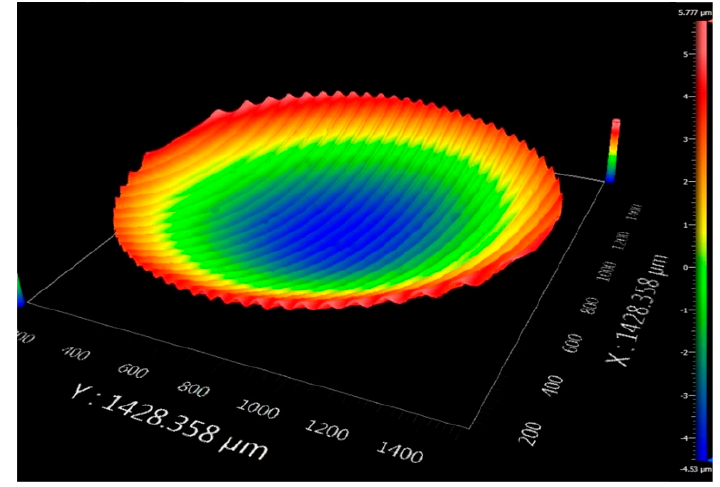
Figure 10. Concave spherical surface topography of titanium alloy machined by a non-resonant three- dimensional elliptical vibration cutting (3D-EVC) apparatus. ( f 3D = 50 mm/min, S = 50 mm/min, A = 7 μ m, D = 1 μ m and F = 0.2 mm·min − 1 ).